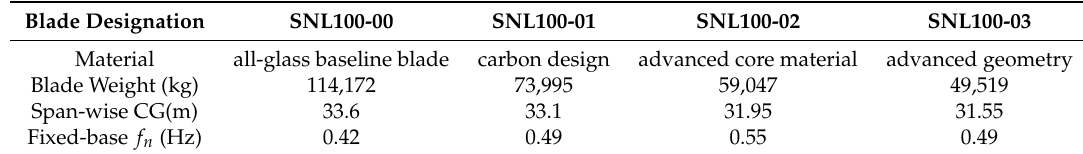
Figure 2. Variation in mass density, flapwise stiffness and edgewise stiffness along the (normalized) length for three Sandia National Laboratories (SNL) 100-m blade designs and for the NREL 5-MW wind turbine blade. Table 1. Key differences between the different SNL 100-m blade